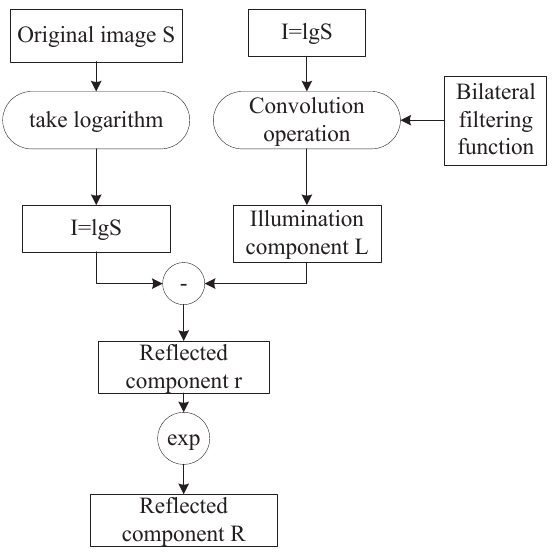
Figure 4. Improved Retinex